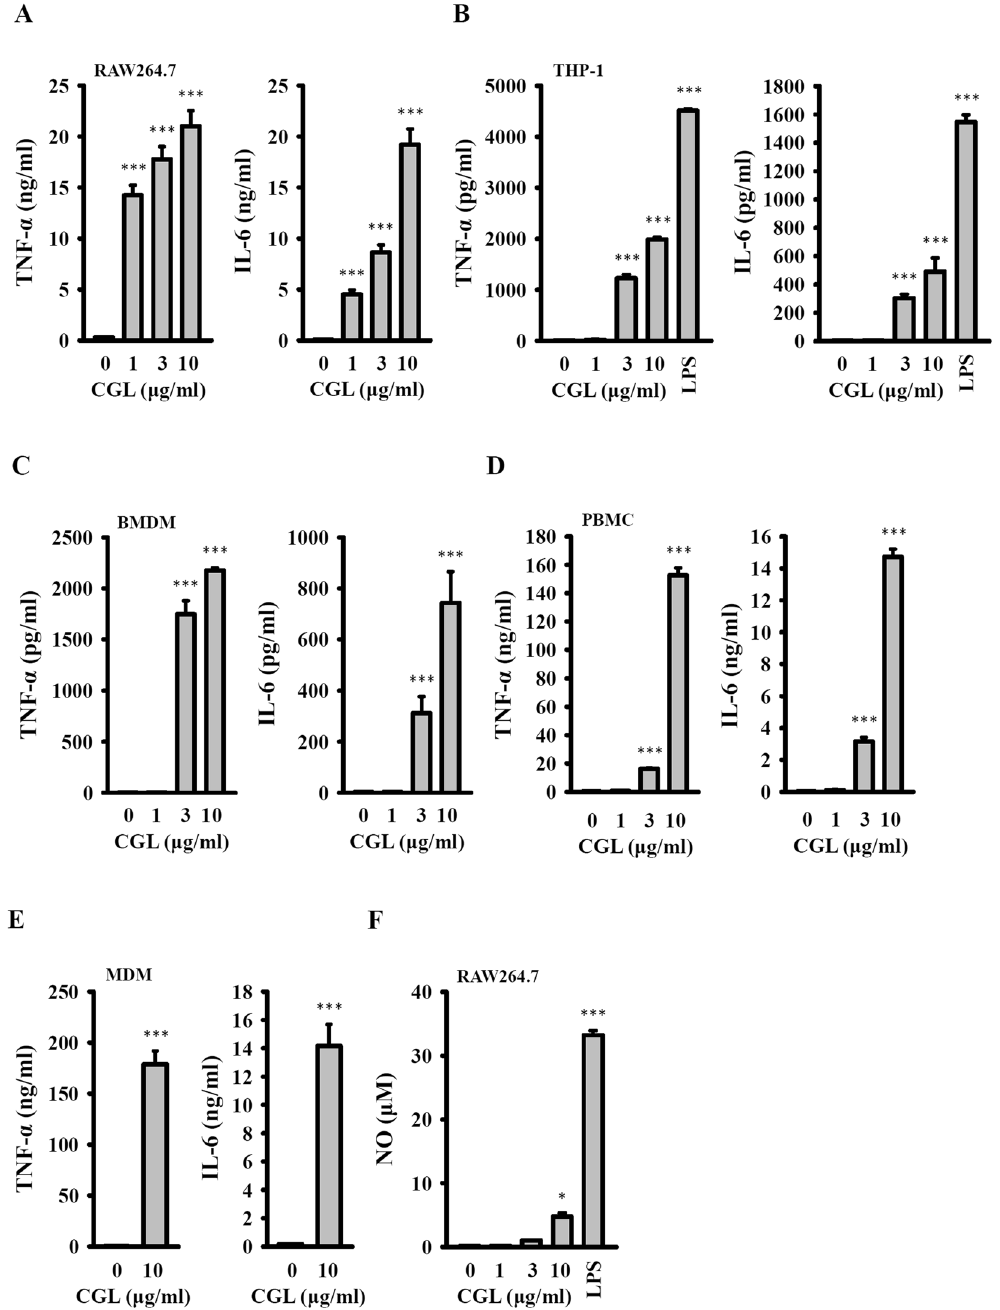
Figure 2. CGL induced cytokine production in macrophages. ( A ) RAW264.7 macrophages, ( B ) human THP-1 macrophages, ( C ) mouse bone marrow-derived macrophages, ( D ) PBMCs and ( E ) MDMs were incubated for 24 h with or without CGL or LPS (1 µ g/ml). The levels of TNF- α and IL-6 in the culture medium were measured by ELISA. ( F ) RAW264.7 macrophages were incubated for 24 h with or without CGL or LPS (1 µ g/ml). The levels of NO in the culture medium were measured by Griess reaction. The NO and ELISA data are expressed as the means ± SD of three separate experiments. * and *** indicate significant differences at the levels of p < 0.05 and p < 0.001, respectively, compared to control